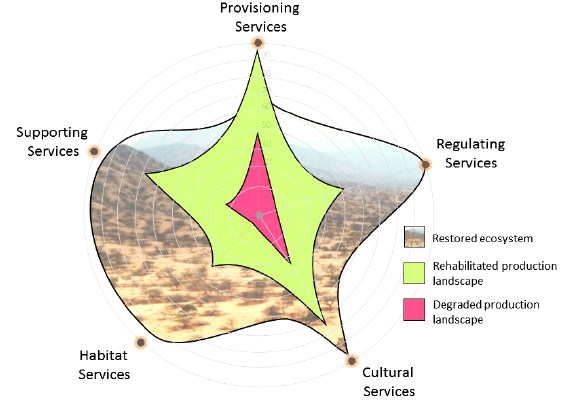
Fig. 2 . Hypothetical levels of the five major types of ecosystem services provided by degraded production landscapes, rehabilitated production landscapes, and restored